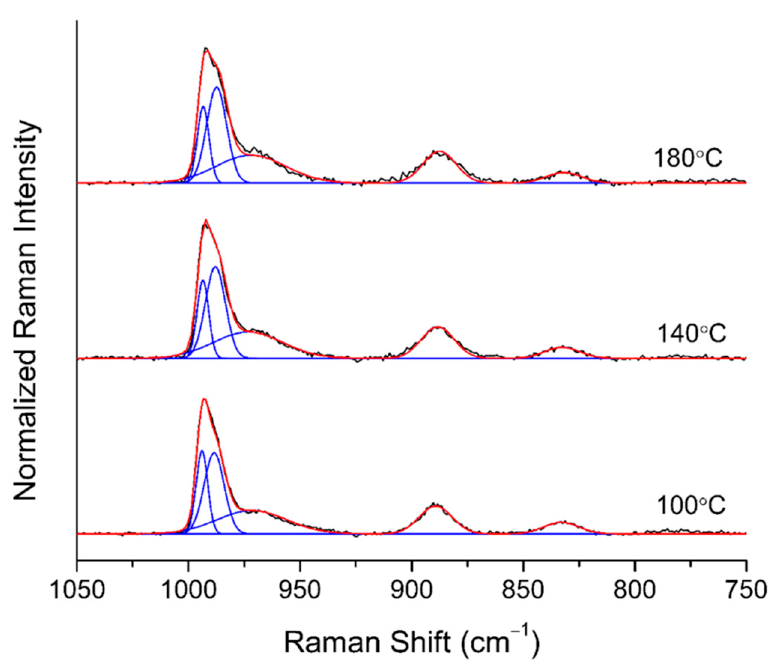
Figure 3. In-situ Raman spectra of a 2 wt% ReO x -Pd/CeO 2 catalyst at 100 °C, 140 °C, and 180 °C under an Ar